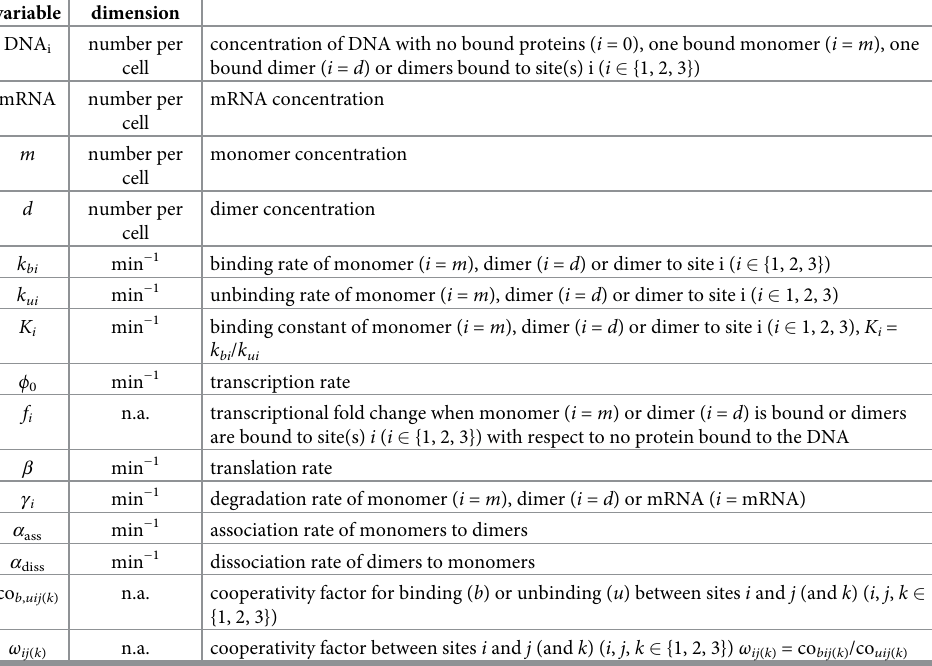
Table 1. Overview of all variables and all parameters of the different